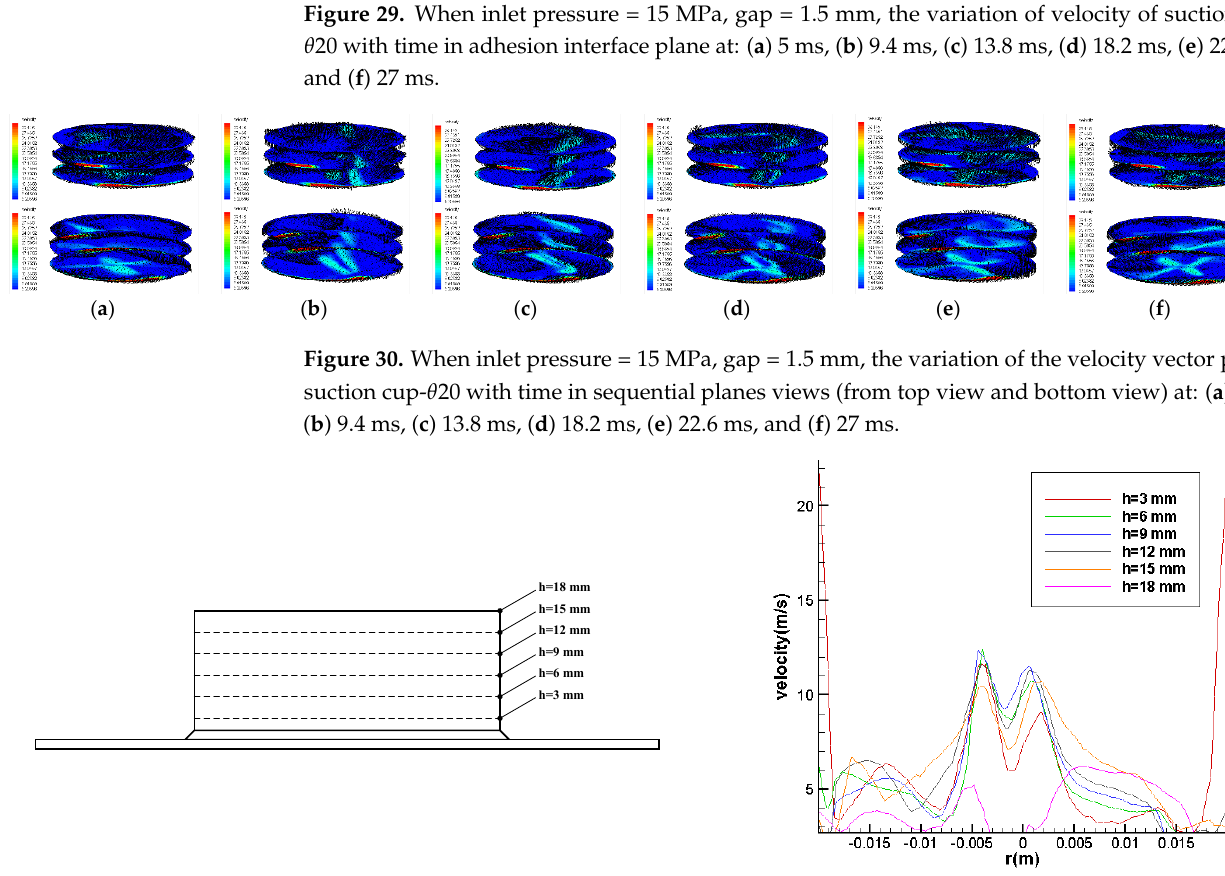
Figure 31. Radial velocity distribution of each section (h = 3, 6, 9, 12, 15, 18 mm). ( a ) The vertical axial cross-plane with sequential height-lines of the suction cup; ( b ) radial velocity distribution of sections corresponding to ( a ).